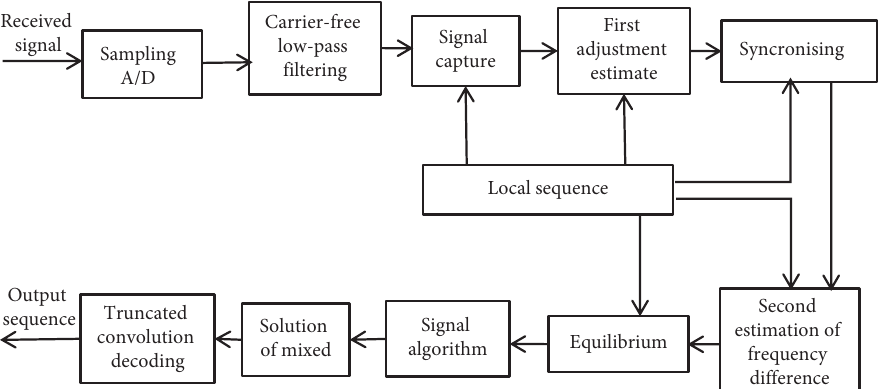
Figure 7: Block diagram of the 8PSK signal demodulation process.